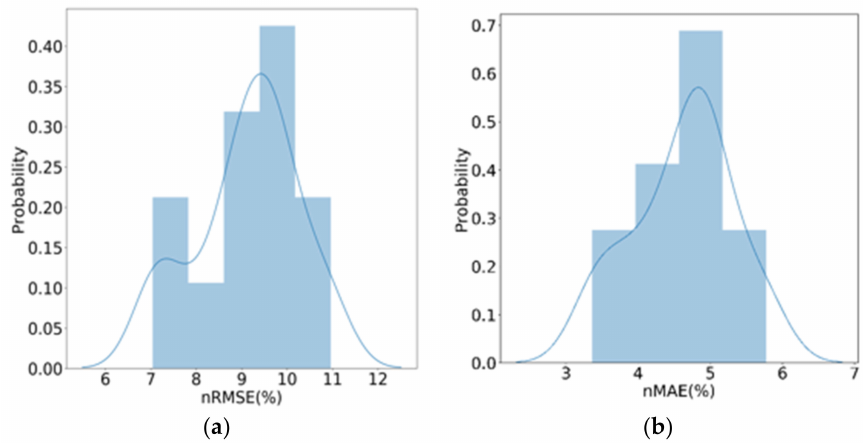
Figure 9. Distribution of individual PV generation forecasting ( a ) nRMSE ( b )